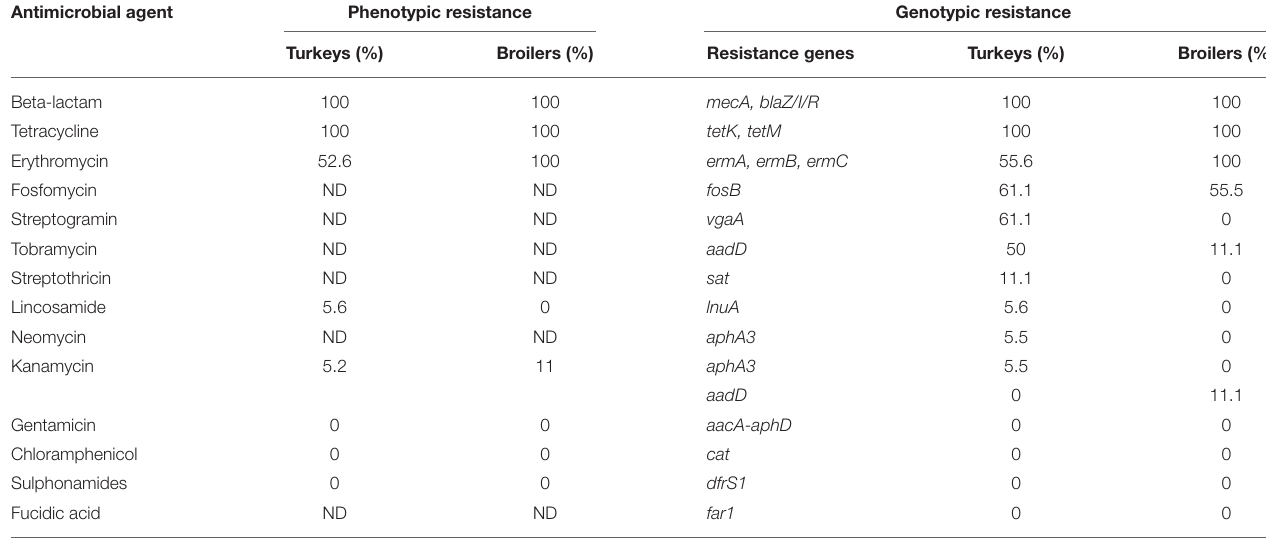
TABLE 5 | Relationship between phenotypic antimicrobial resistance and detection of resistance genes in MRSA isolated from turkeys and broilers. Antimicrobial